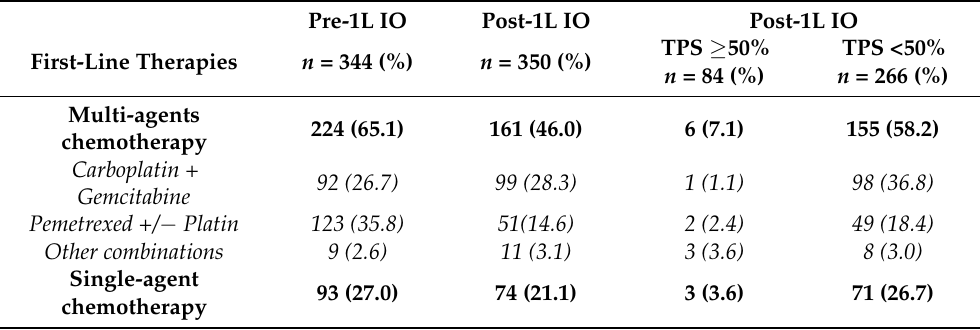
Table 2. First-line treatments administrated by Pre- and Post-1L IO cohorts. Post-1L IO cohort